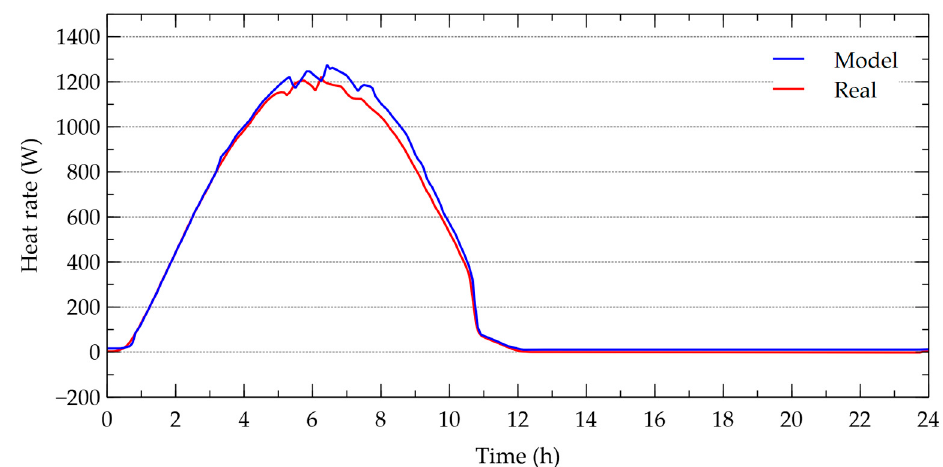
Figure 7. Estimated absorbed heat rate.